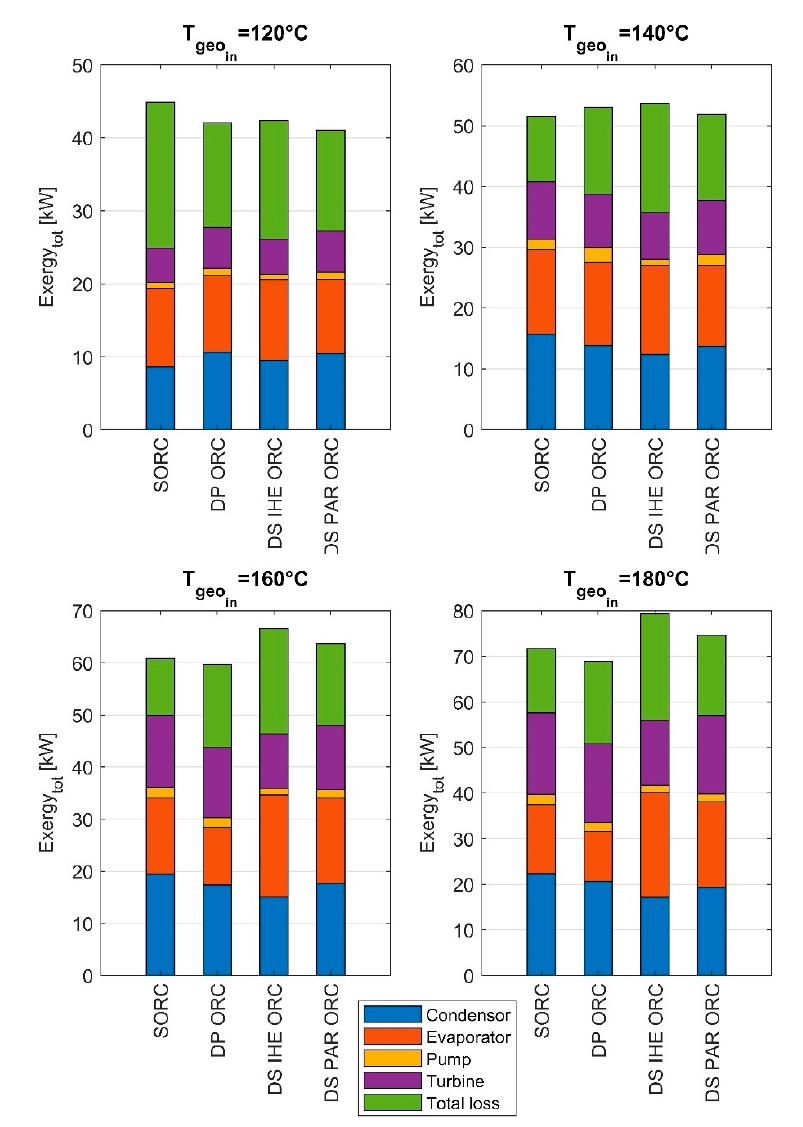
Figure 10. The results of the conventional exergy